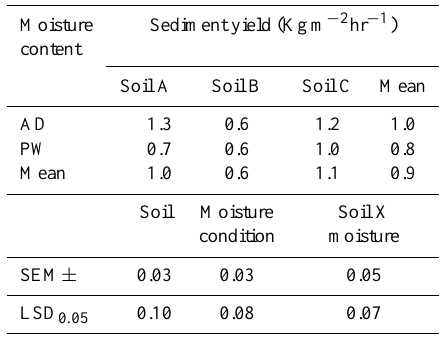
Table 7. Effect of the different combinations of soil type and mois- ture content on sediment yield.